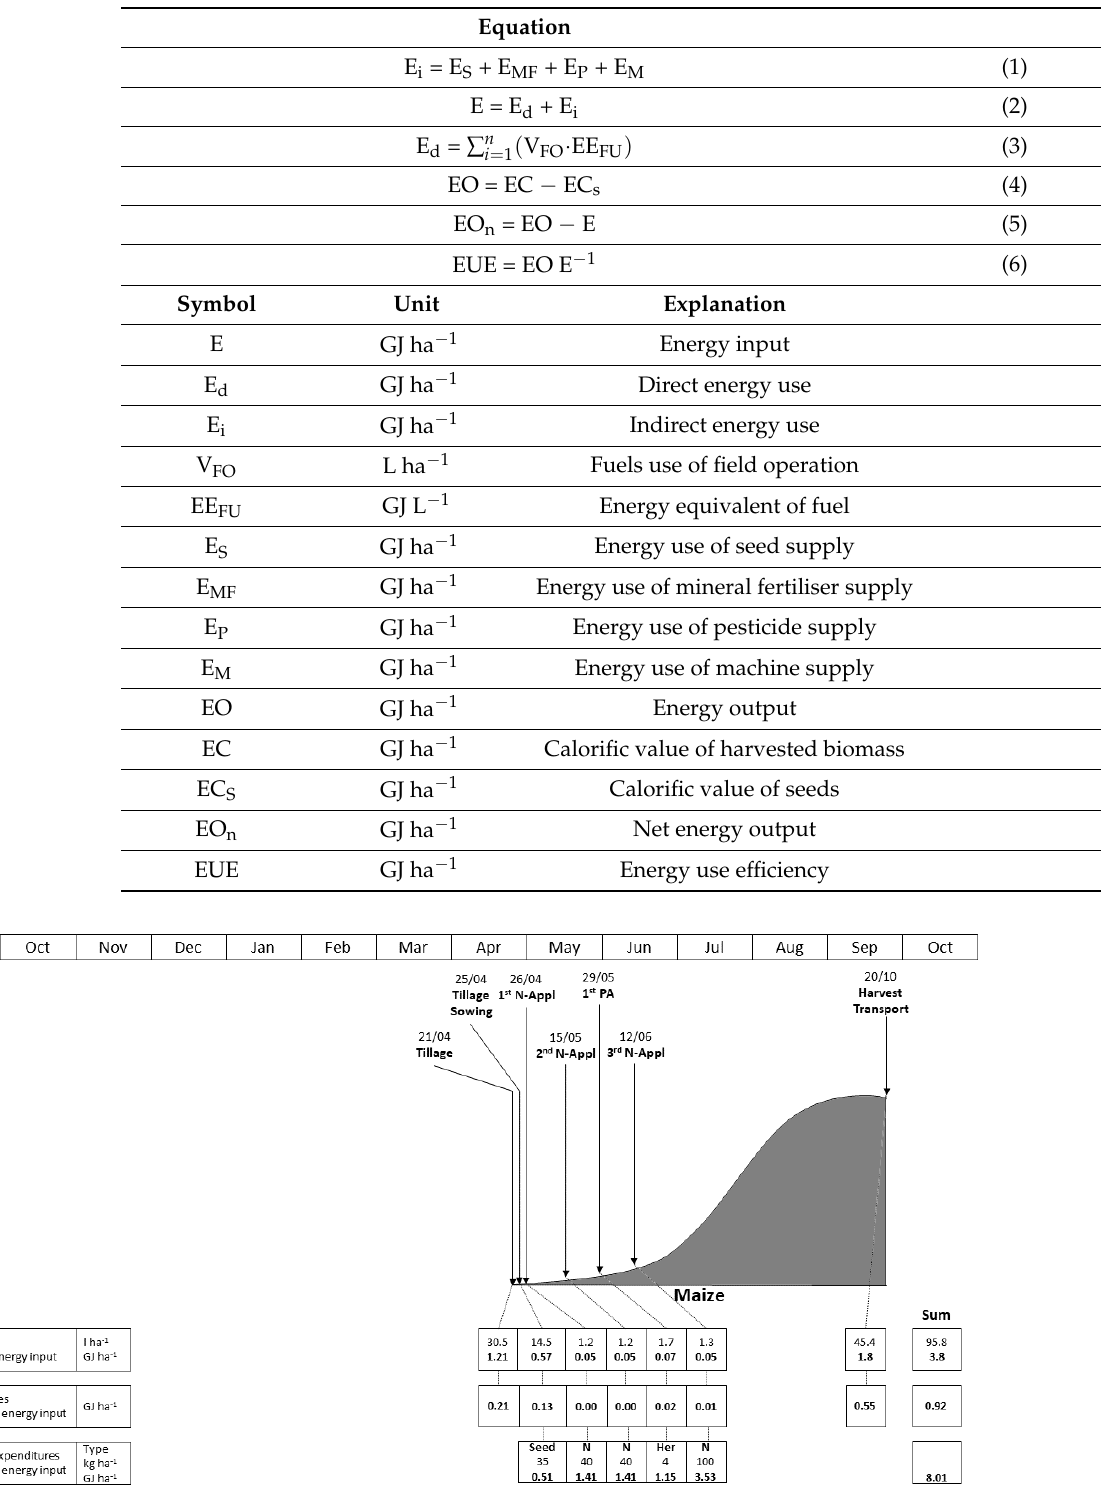
Table 3. Net energy output and energy efficiency were calculated based on Equations (1)–(6).